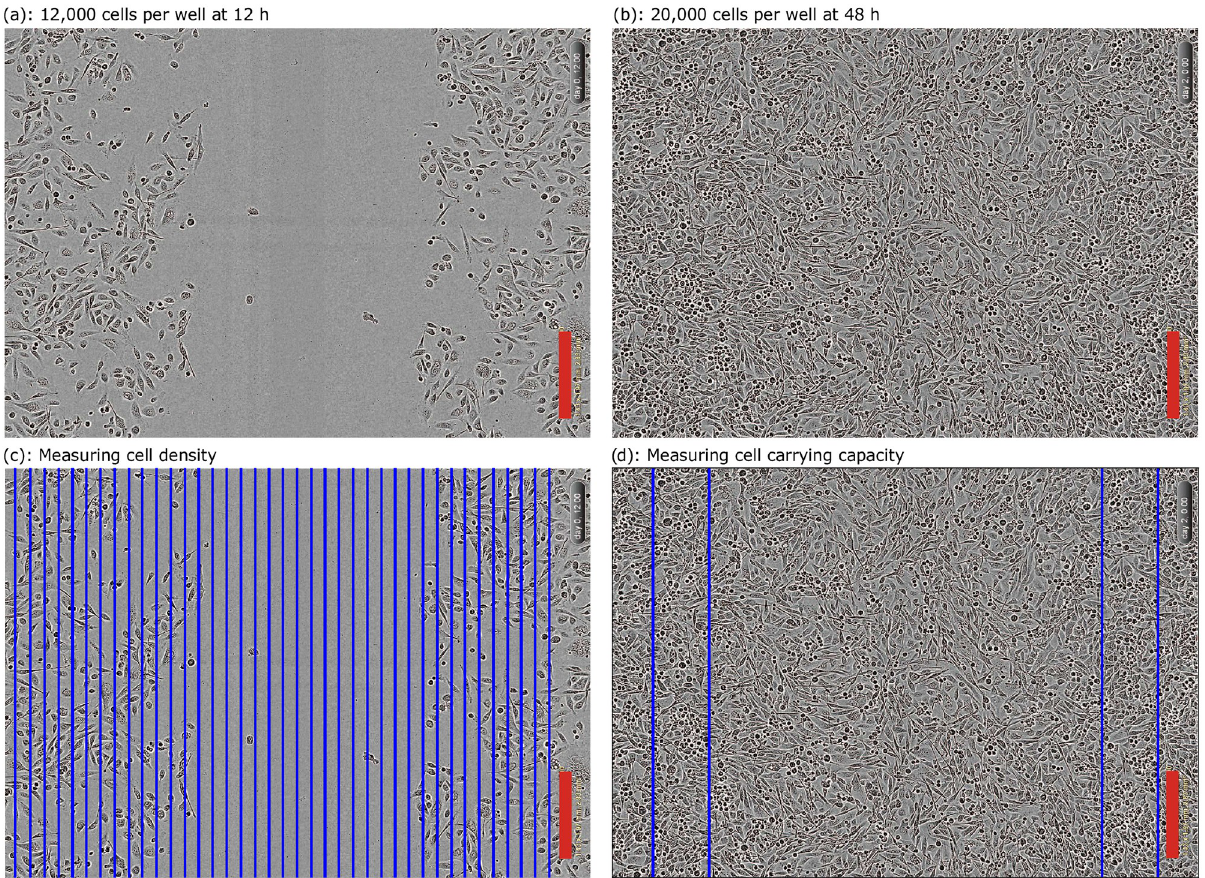
Fig 2. Measuring cell density cell carrying capacity. (a) and (b) are two images from the experiment of Jin et al. [13] with the initial CPW and times shown. The red scale bar corresponds to 300 μ m. (c) Illustration of how the images are split into columns, shown in blue, with cells counted for each column to measure the cell densities. (d) The carrying capacity density is measured by counting the number of cells for the 20,000 CPW data set at t = 48 h in the blue rectangles shown, divided by the area of these